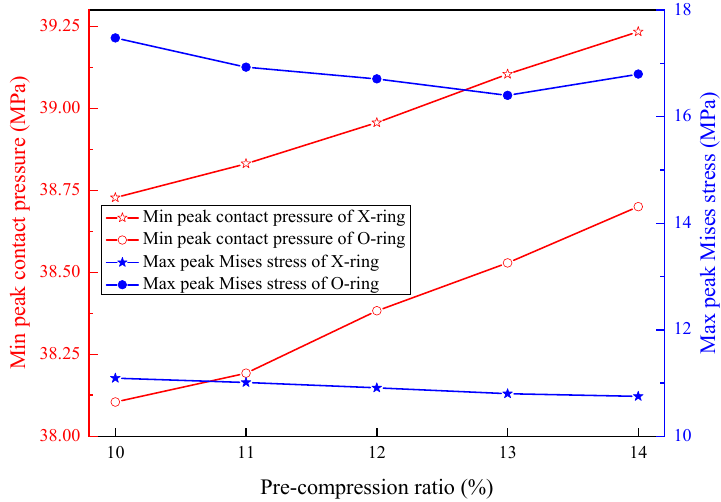
Figure 17. Min peak contact pressure and max peak Mises stress of X-ring and O-ring during 1–2 T in various R p .